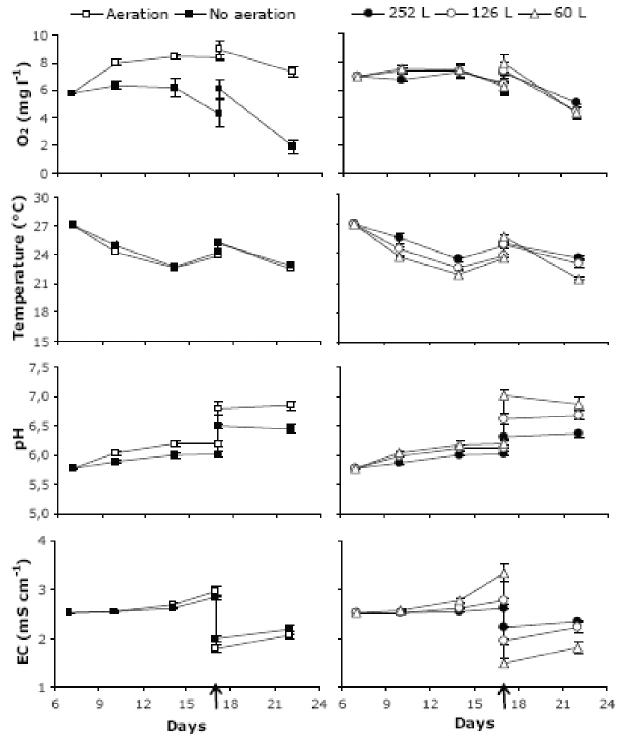
Fig. 1 - Effect of aeration (left) and volume (l per m 2 of cultivated area) (right) of the nutrient solution on its O 2 concentration, tem- perature, pH and EC during the summer cultivation cycle of spinach. Error bars (± SE ) are shown when larger than sym- bols. Arrows indicate the date when the consumed solution was restored with tap